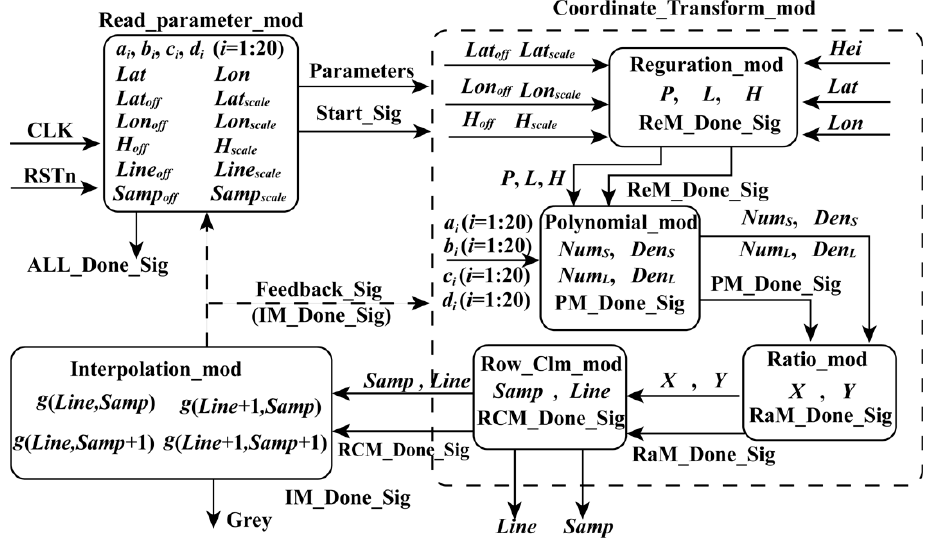
Figure 1. Flowchart showing implementation on an FPGA chip.